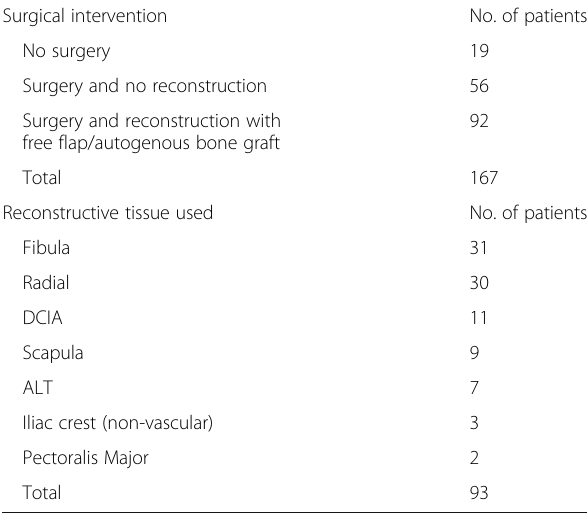
Table 3 Summary of surgical interventions and tissue type used for head and neck reconstruction Surgical intervention